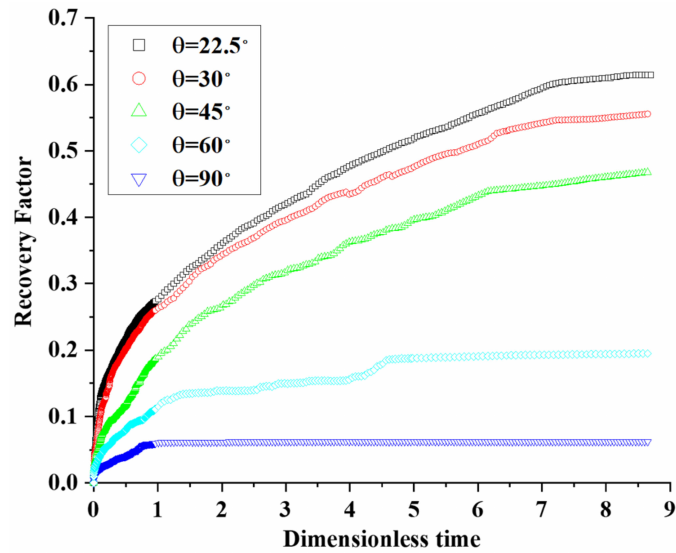
Figure 16. Recovery factor with different contact angles.